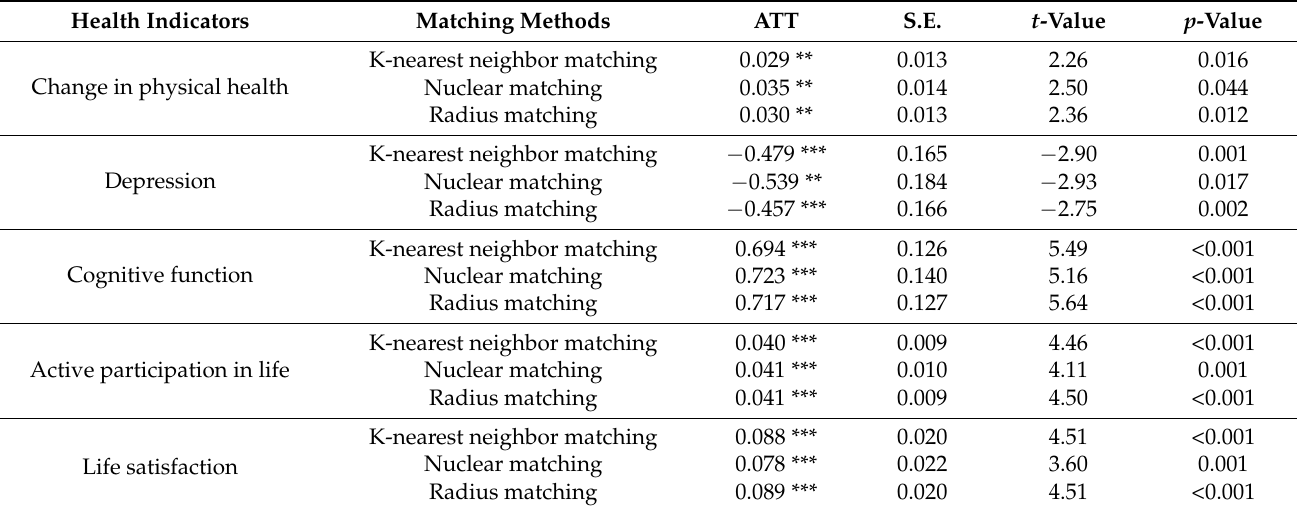
Table 4. ATT of using home and community care services on the multidimensional health of older adults.